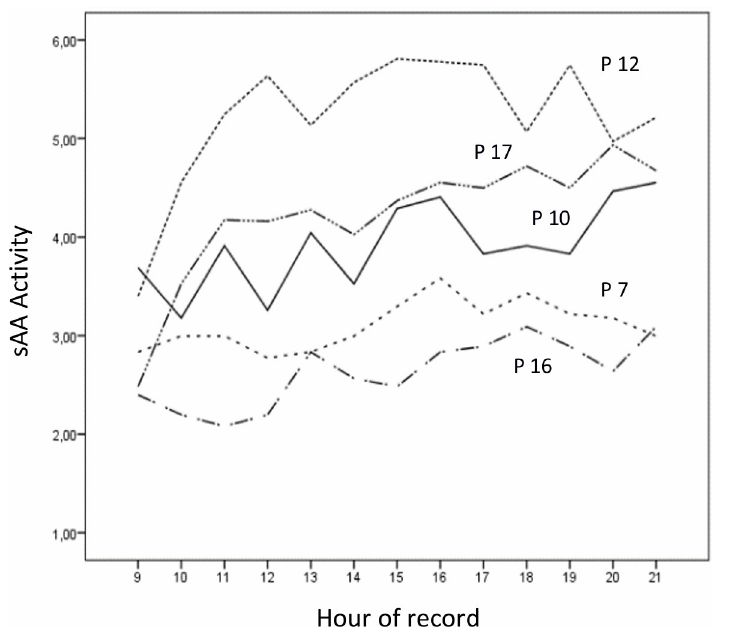
Fig 1. Original sAA records of participants (P) 7, 10, 12, 16 and